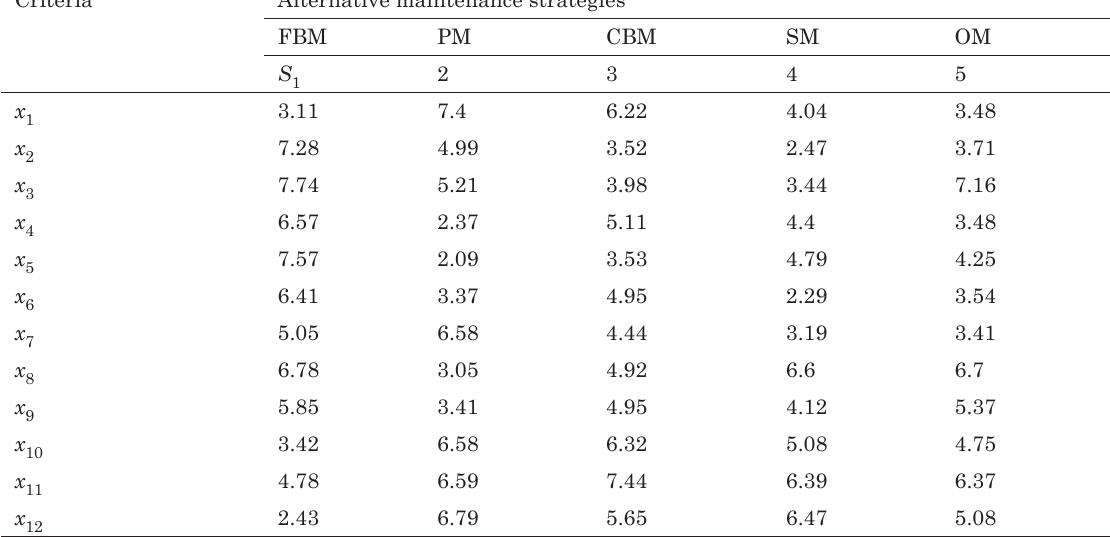
table 6. Crisp values for decision matrix Criteria